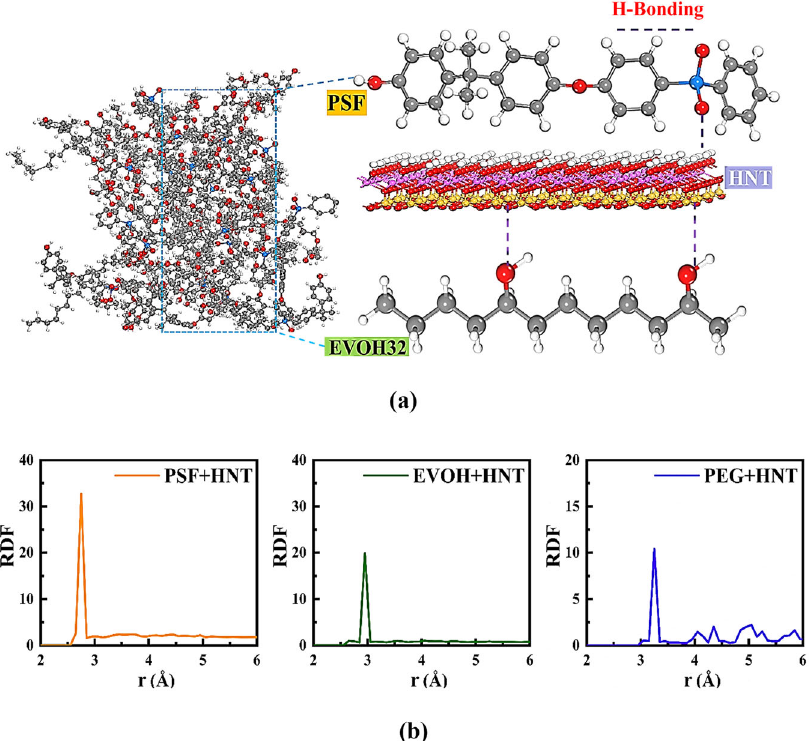
Fig. 2 MD simulations. a The amorphous structure of the PSF/EVOH/PEG/HNT system, with the magni fi ed section on the right exhibiting H-bonding interaction between PSF and HNT, EVOH and HNTs, and PEG and HNT. C: black, H: white, O: red, S: yellow; ( b ) RDF calculation of PSF and HNTs; EVOH and HNTs; and of PEG and